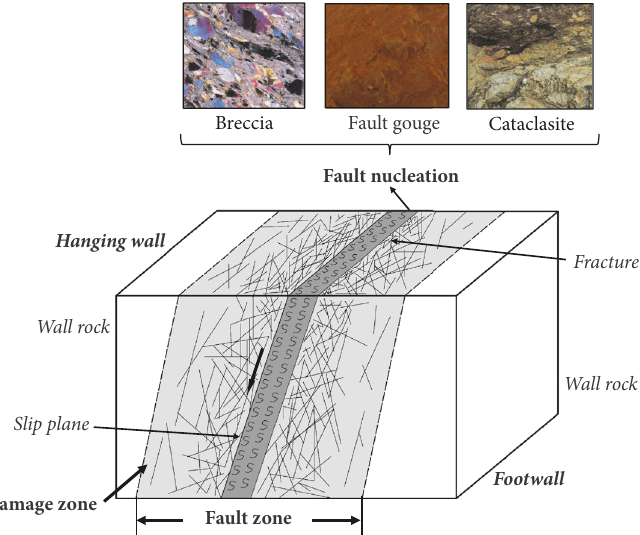
Figure 2: Structure diagram of ductile shear